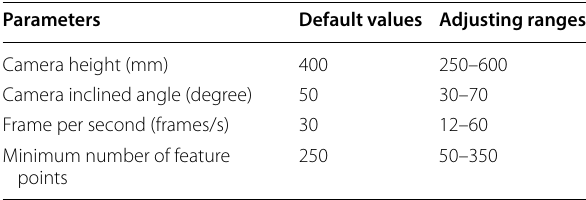
Table 4 Default values of the concerned parameters